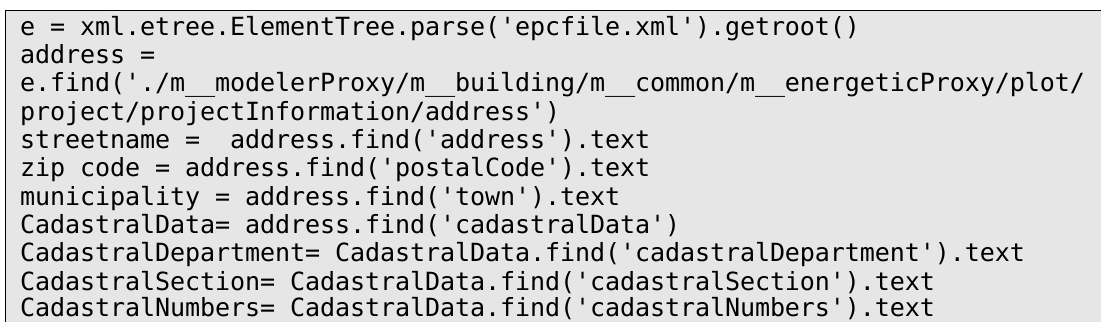
Figure 3. Data extraction methodology of the developed Python algorithm. Figure 4 Data extraction methodology of the developed Python algorithm.